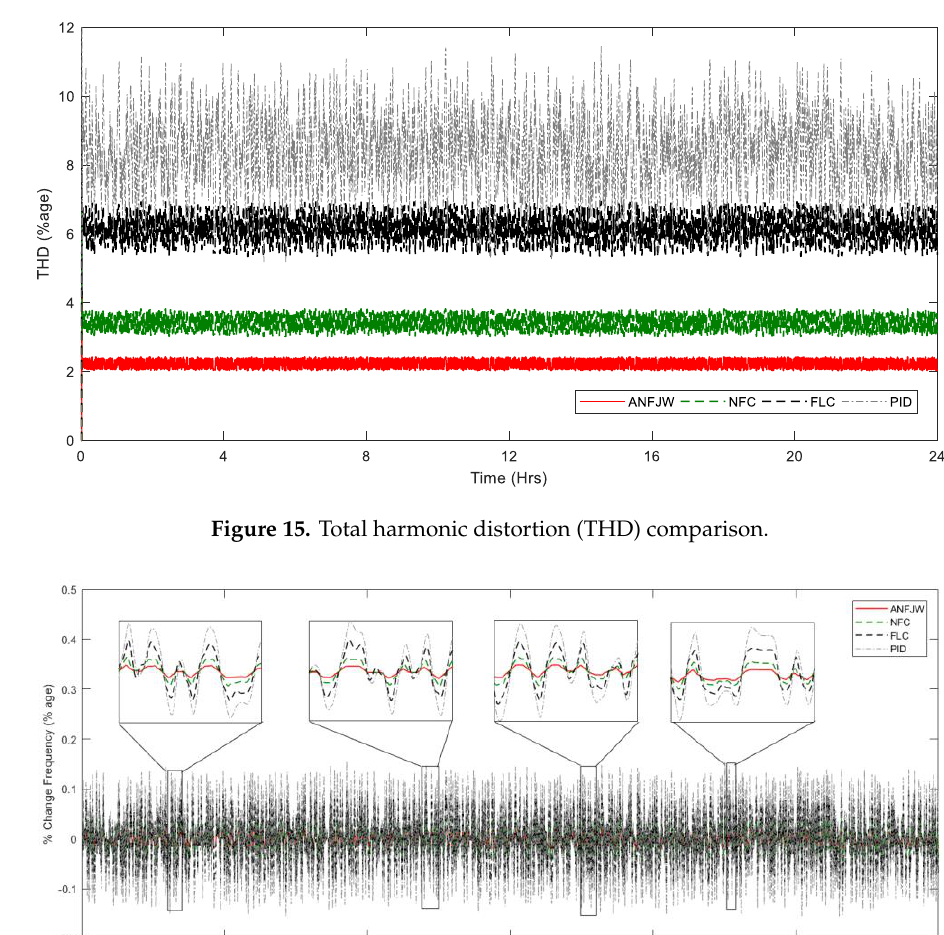
Figure 14. Output reactive power comparison at different intervals. Energies 2020 , 13 , x FOR PEER REVIEW